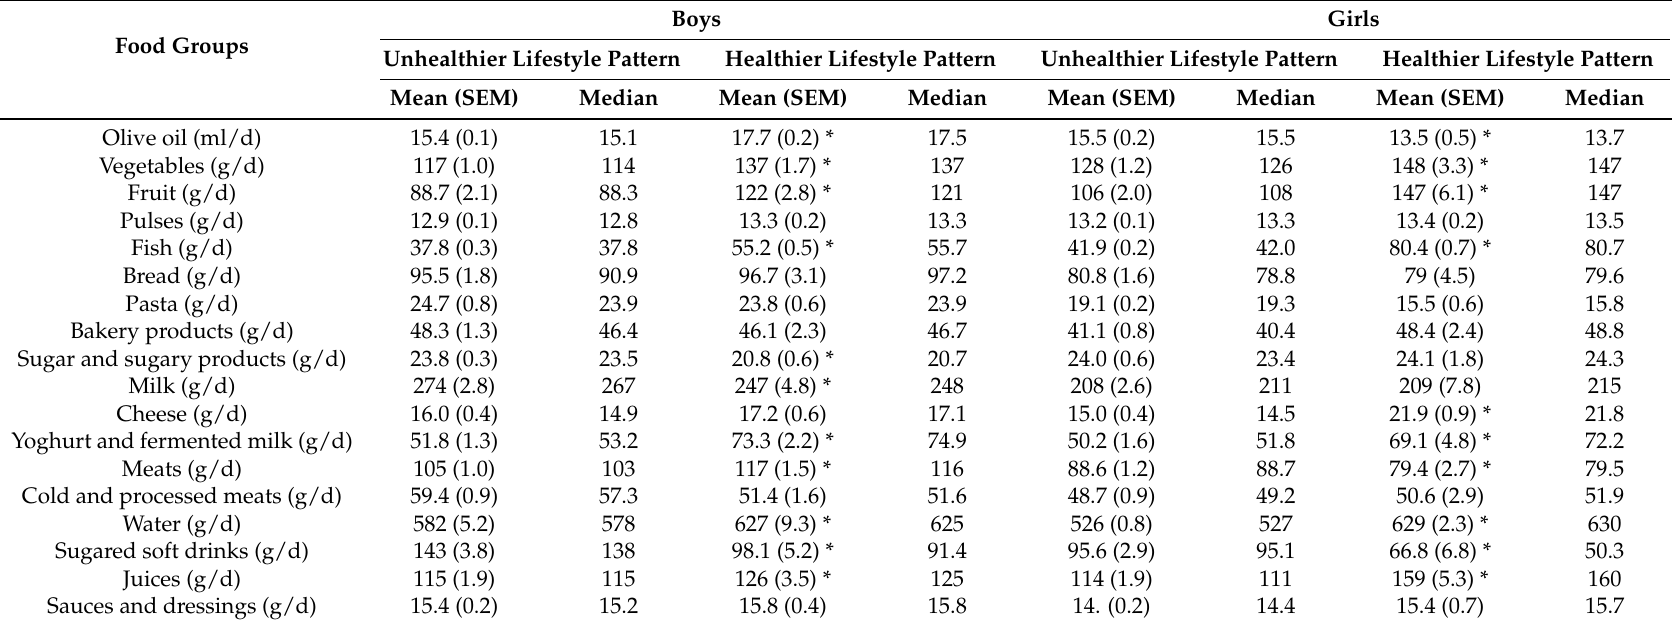
Table 3. Mean and median consumption of selected food groups and beverages by lifestyle pattern a in boys and girls b .